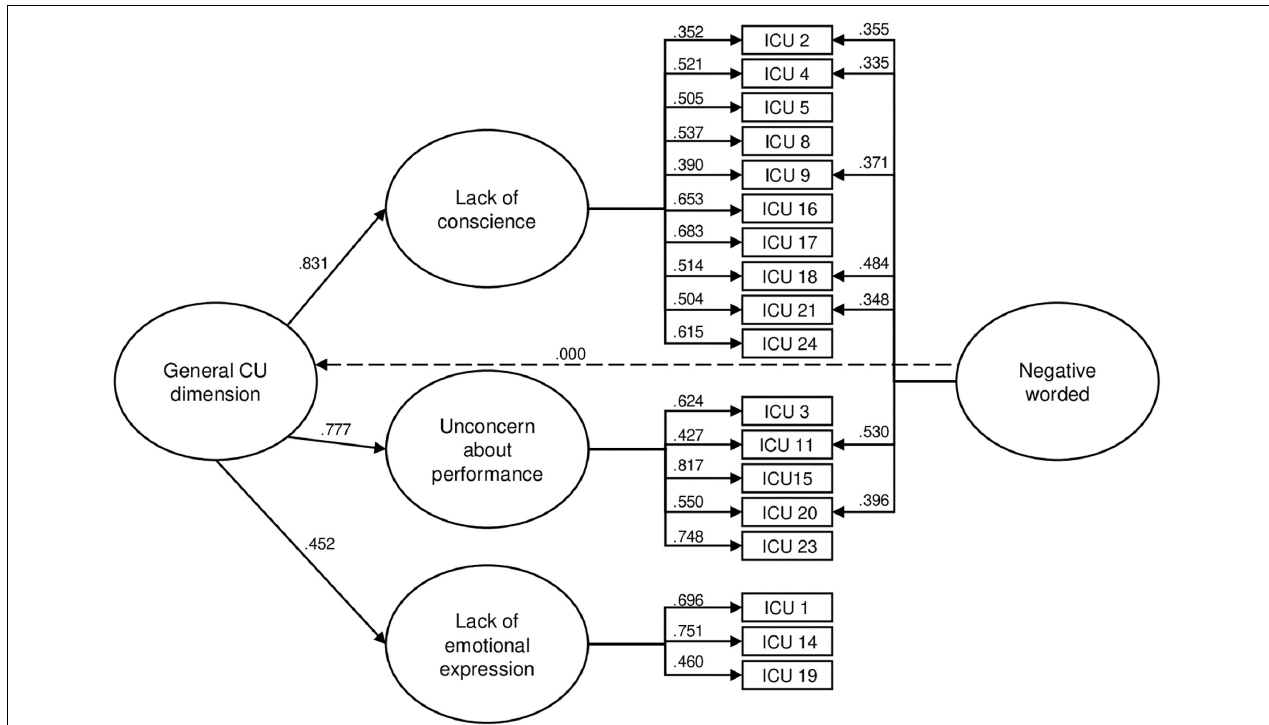
FIGURE 1 | Model 5 with modifications – 18-item Second Order Model with Three First Order Factors, a Second Order Latent Factor and a Methodological Latent Factor. Items 6, 7, 10, 12, 13, and 22 were removed. Standardized factor loadings are